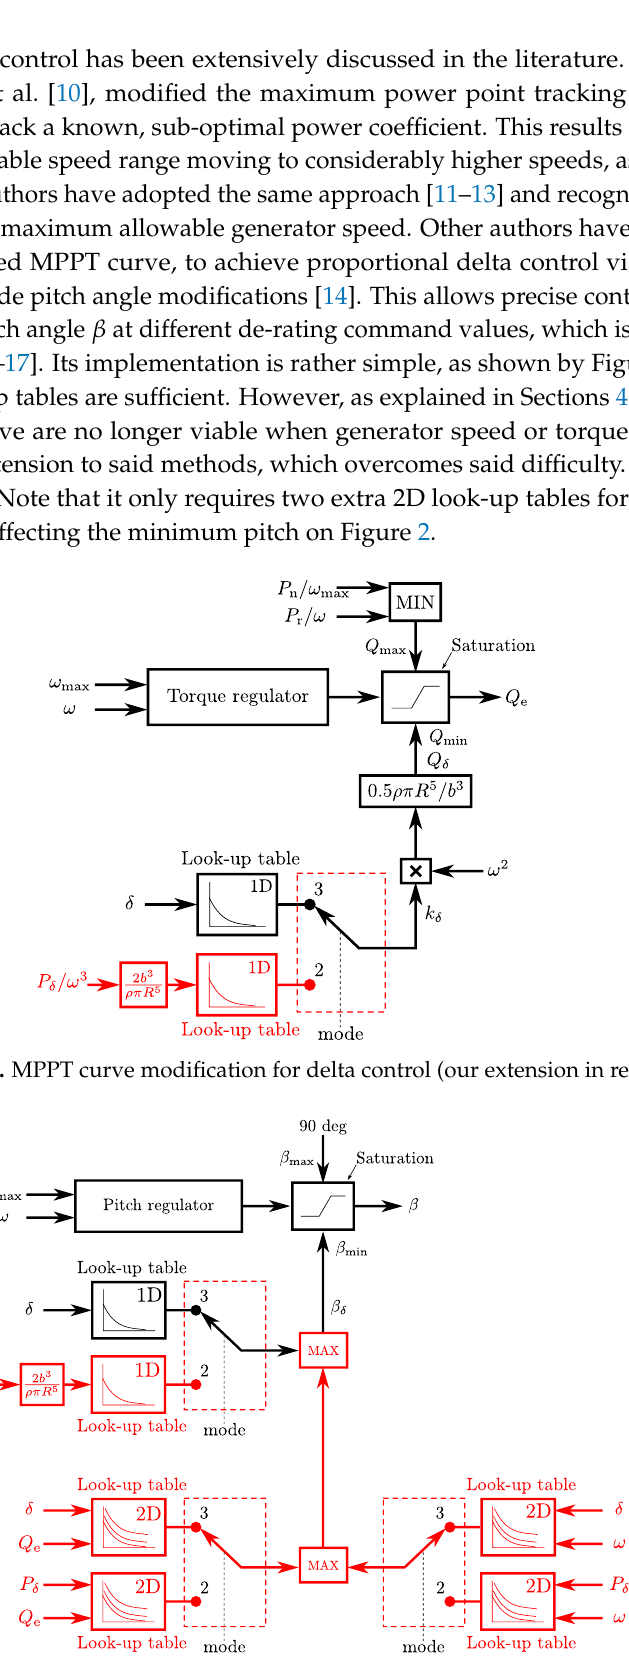
Figure 2. Minimum pitch modification for delta control (our extension in